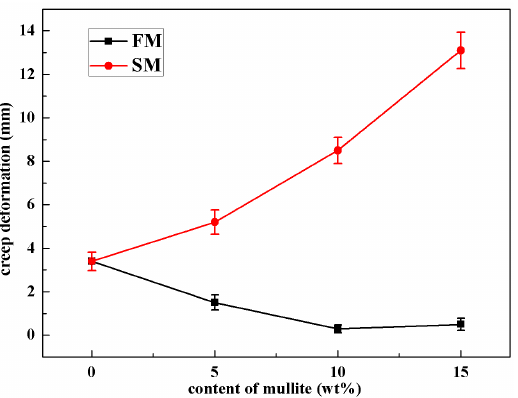
Figure 10. Creep deformation at 1540 °C of the ceramic cores with different amounts of mullite powders.